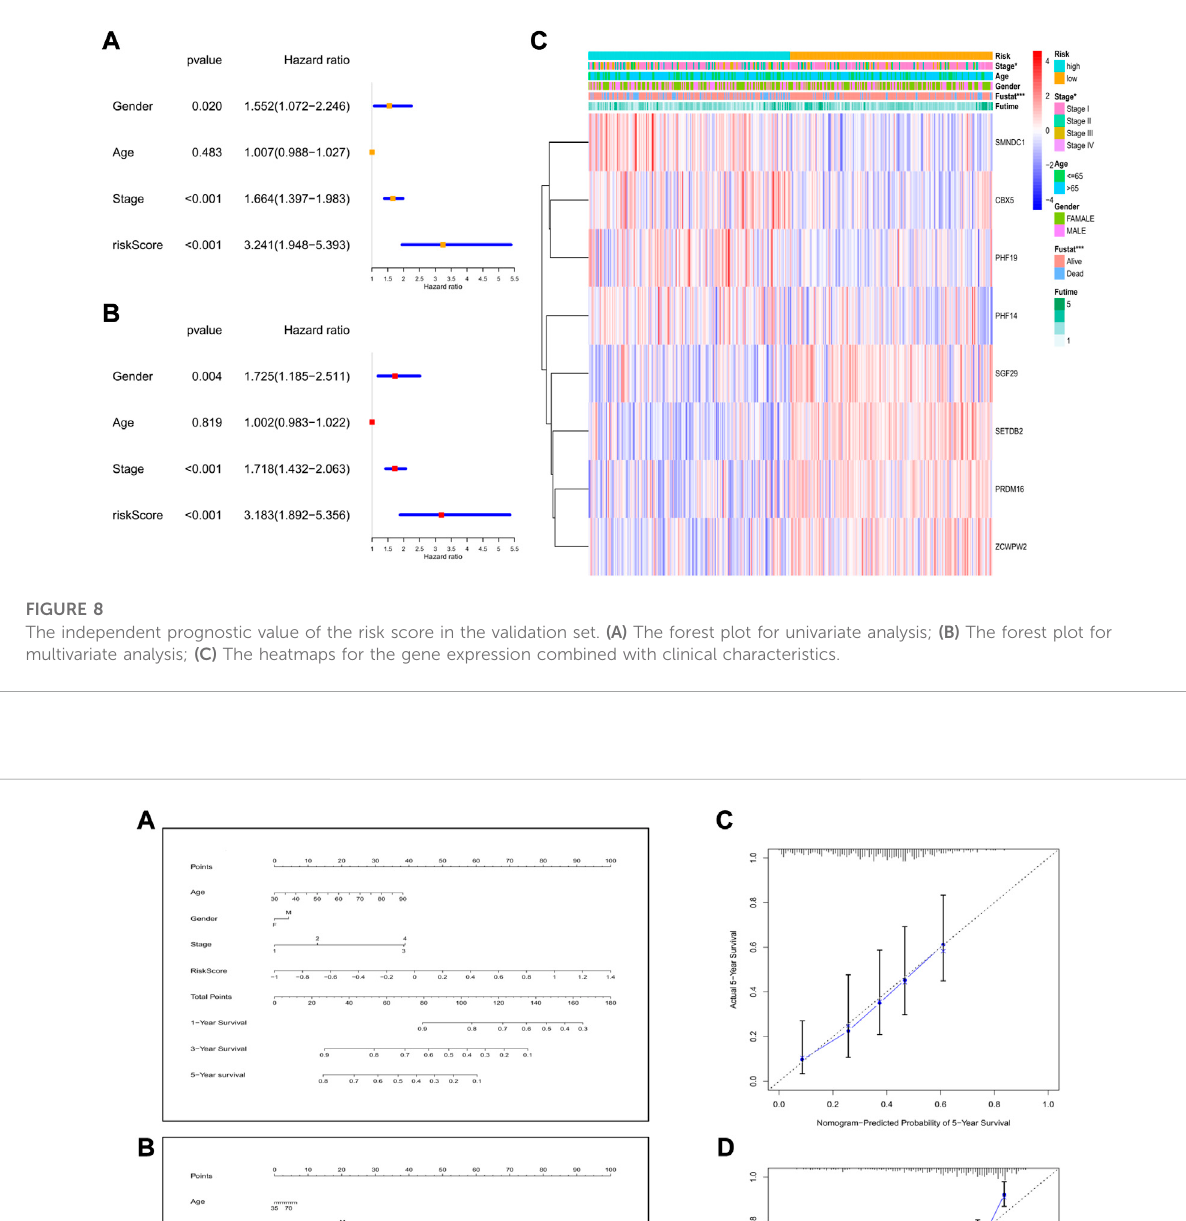
Frontiers in Cell and Developmental